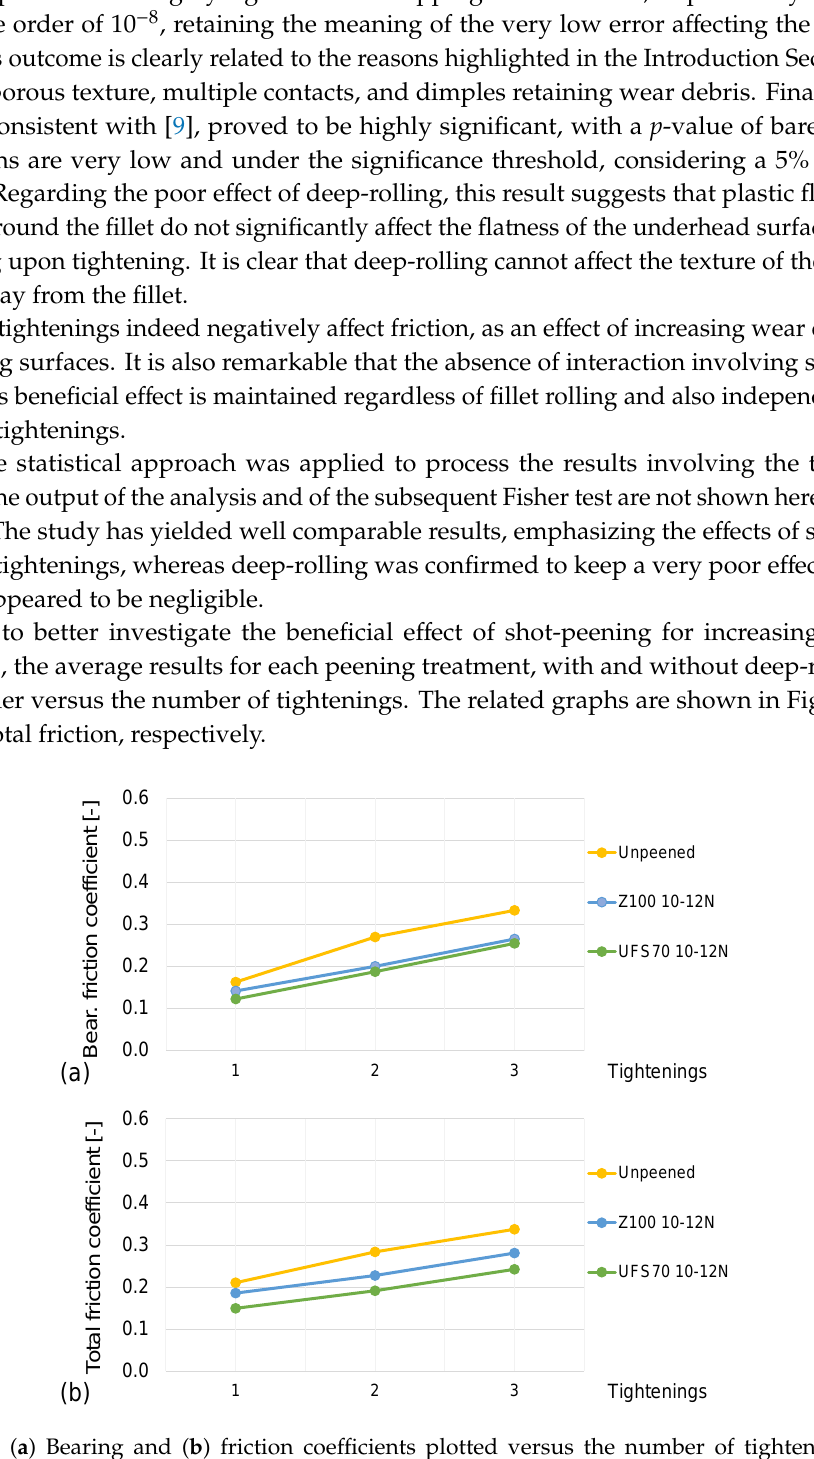
Figure 4. ( a ) Bearing and ( b ) friction coefficients plotted versus the number of tightenings for different peening treatments, with regard to the trials in dry conditions (data averaged regardless of deep-rolling execution).